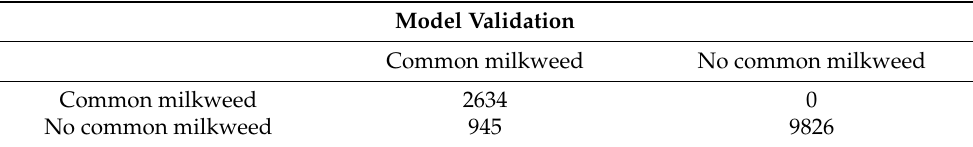
Table 3. Validation of the SVM